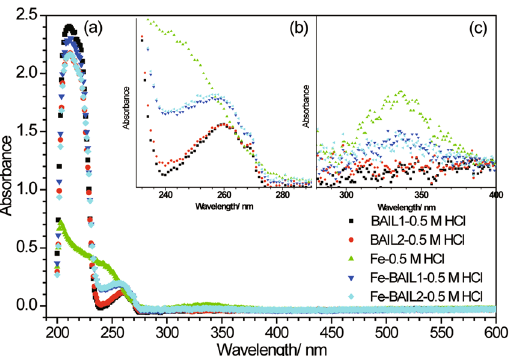
Figure 11. UV–visible spectra of 0.5 M HCl solution without/with 0.75 mM BAIL1 and BAIL2 before and after steel immersion of 24 h. Note: 0.5 M HCl solution + BAIL1 ( ); 0.5 M HCl solution + BAIL2 ( ); 0.5 M HCl solution after steel immersion ( ); 0.5 M HCl solution + BAIL1 after steel immersion ( ); 0.5 M HCl solution + BAIL2 after steel immersion (